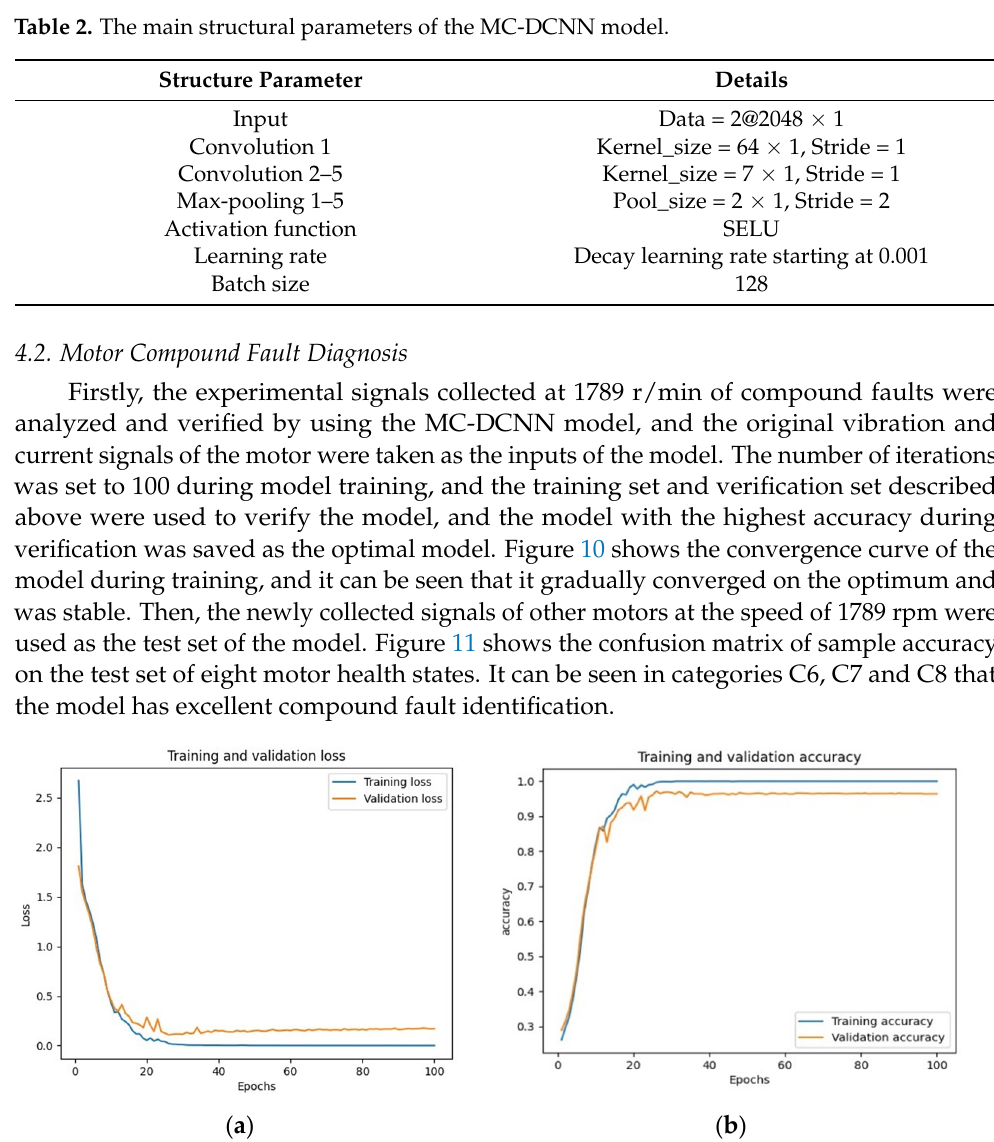
Figure 10. Convergence curves of the model under the action of the training set and test set: ( a ) loss; ( b ) accuracy.